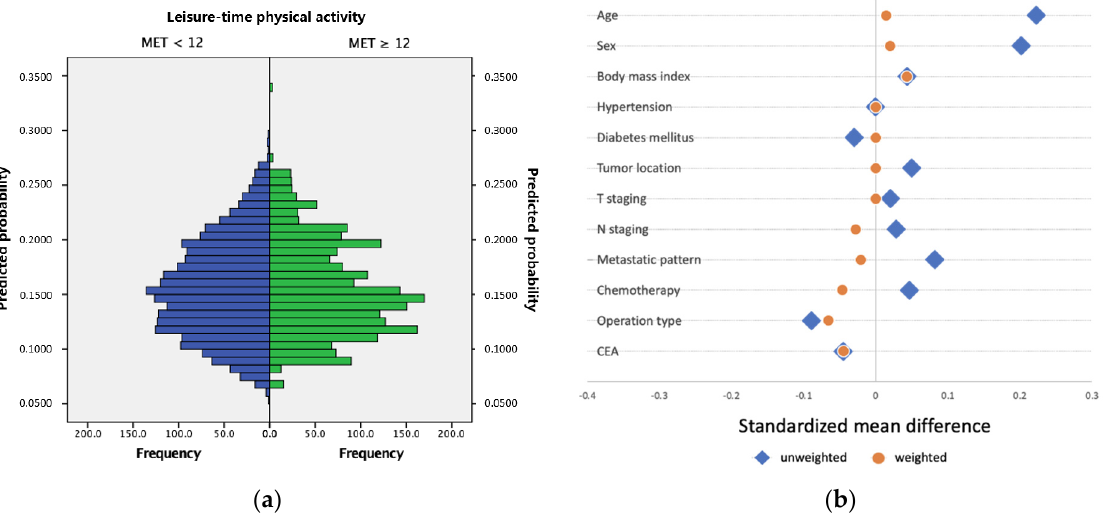
Figure 2. ( a ) Distribution of the propensity scores after inverse probability of treatment weighting (IPTW) for groups of weekly metabolic equivalent of task (MET) < 12 and MET ≥ 12. ( b ) Standard- ized mean differences in the unweighted and propensity score-weighted data analyses. Given the difference in baseline variables between the MET < 12 and MET ≥ 12 groups, a propensity score– based IPTW method was performed to balance the baselines of the two groups. After weighting, all between-group standardized mean differences were<0.1. Values of standardized mean differences between the two groups and the observed power for each test before and after weighting were shown in Table S1. Table 1. Patient demographic characteristics and clinicopathological